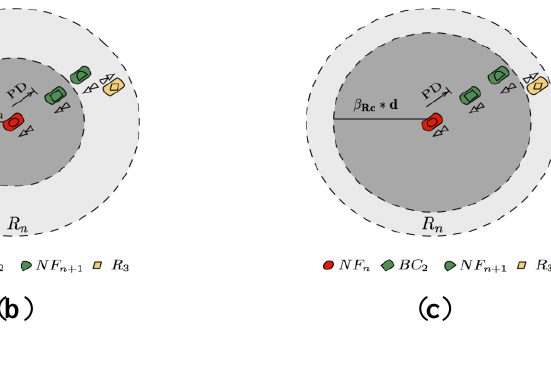
Figure 1. Use of the dynamic factors . and to adjust the nominal radio range, , for vehicles belonging to the and sets. ( a ) Nominal radio coverage ; ( b ) Adjusted radio range for vehicles traveling in opposite direction and moving away ( set). ( c ) Adjusted radio range for vehicles traveling in the same direction ( set).